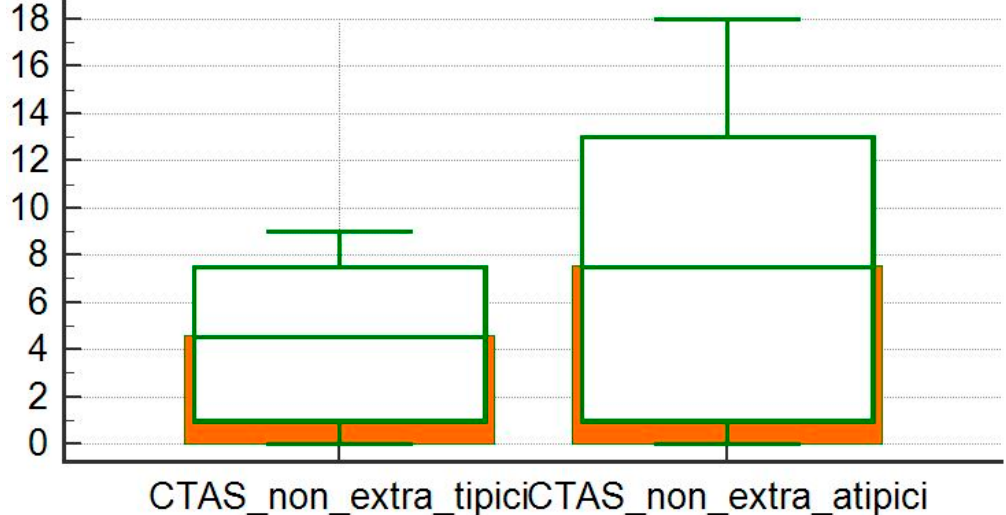
Figure 9. Comparison of CTAS averages between typical and atypical subgroups of patients without extra-thoracic localization.